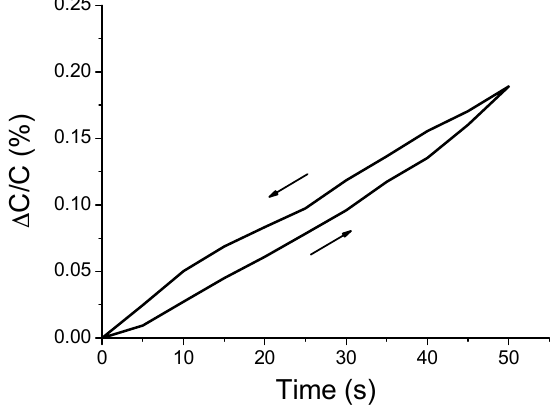
Figure 11. Capacitance change of the air-gap touch sensor upon the application and release of the force of 1 N.